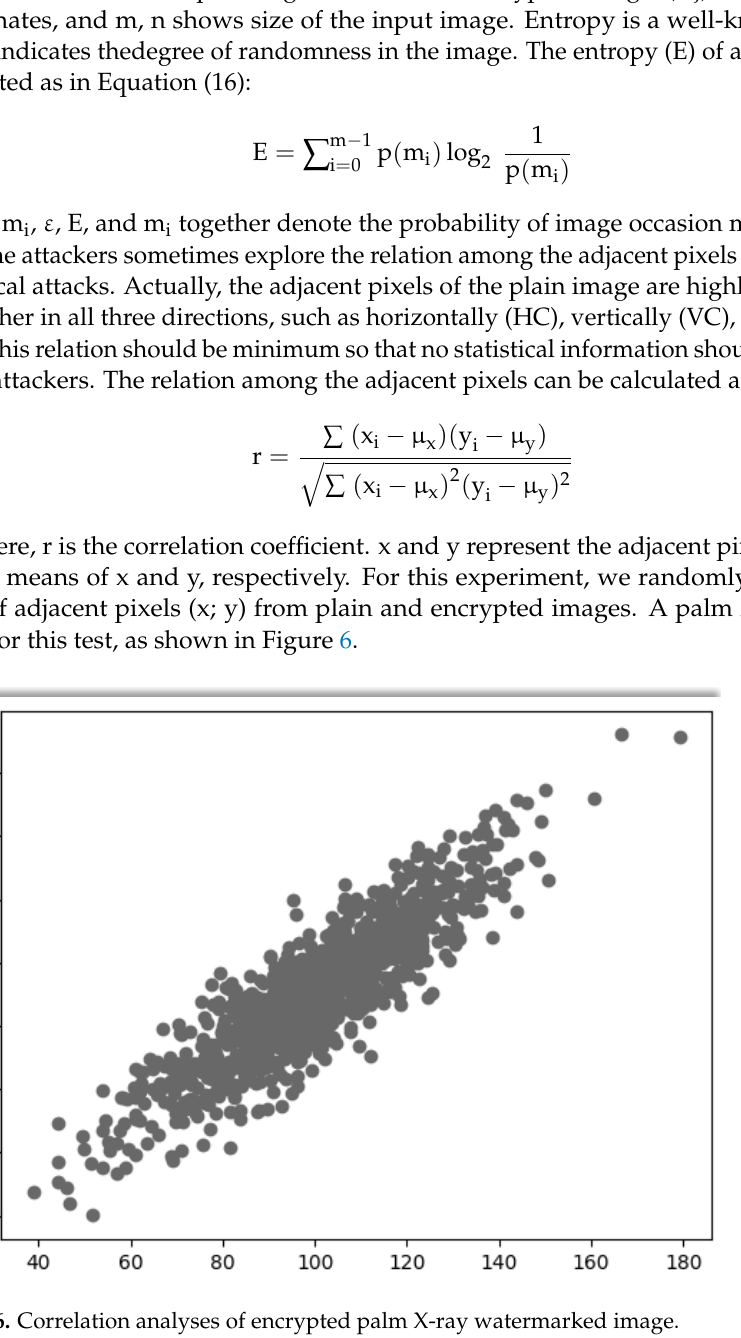
Figure 6. Correlation analyses of encrypted palm X-ray watermarked image .